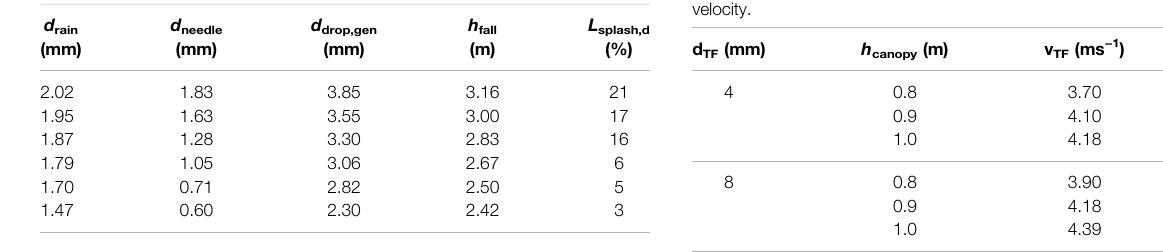
TABLE 1 | Drip experiment results. Variables shown are: observed splash loss (L splash,d )fortherepresentedraindropsize( d rain ),togetherwiththediameterof the needles (d needle ) used for generating the drops of diameter (d drop,gen ) and the adjusted falling height (h fall ) to obtain the kinetic energy representing the rain drop diameter.